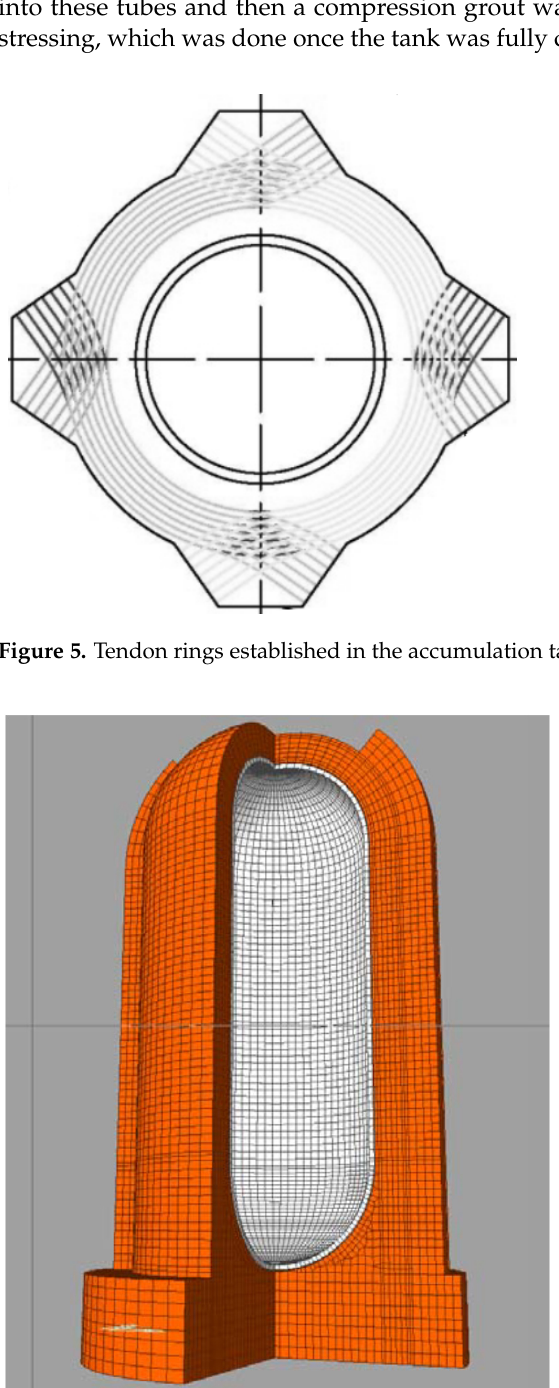
Figure 6. Accumulation tank conceptual design.